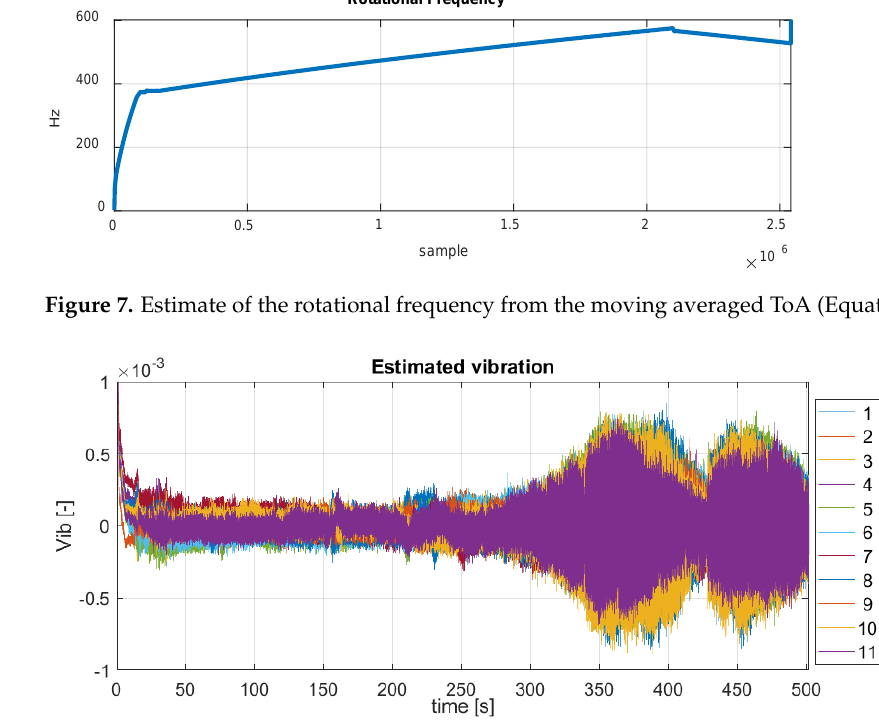
Figure 8. Estimate of the blade vibration with the proposed algorithm (in angular fraction adimensional units, see Equation (12)) for all the 11 blades — see Equation (8).